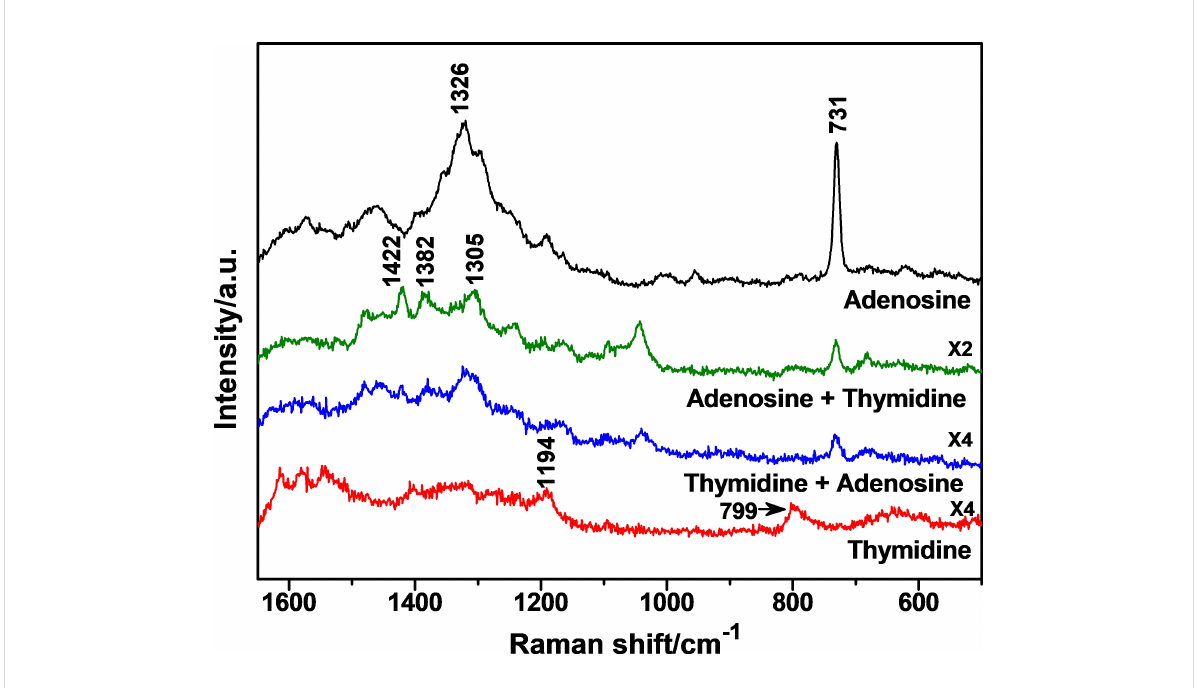
Figure 6: SERS spectra of adenosine and thymidine (both 10 µM), and the surface mixture of adenosine and thymidine obtained by employing the paper-based substrate Ag-NP/cellulose-NF–C.